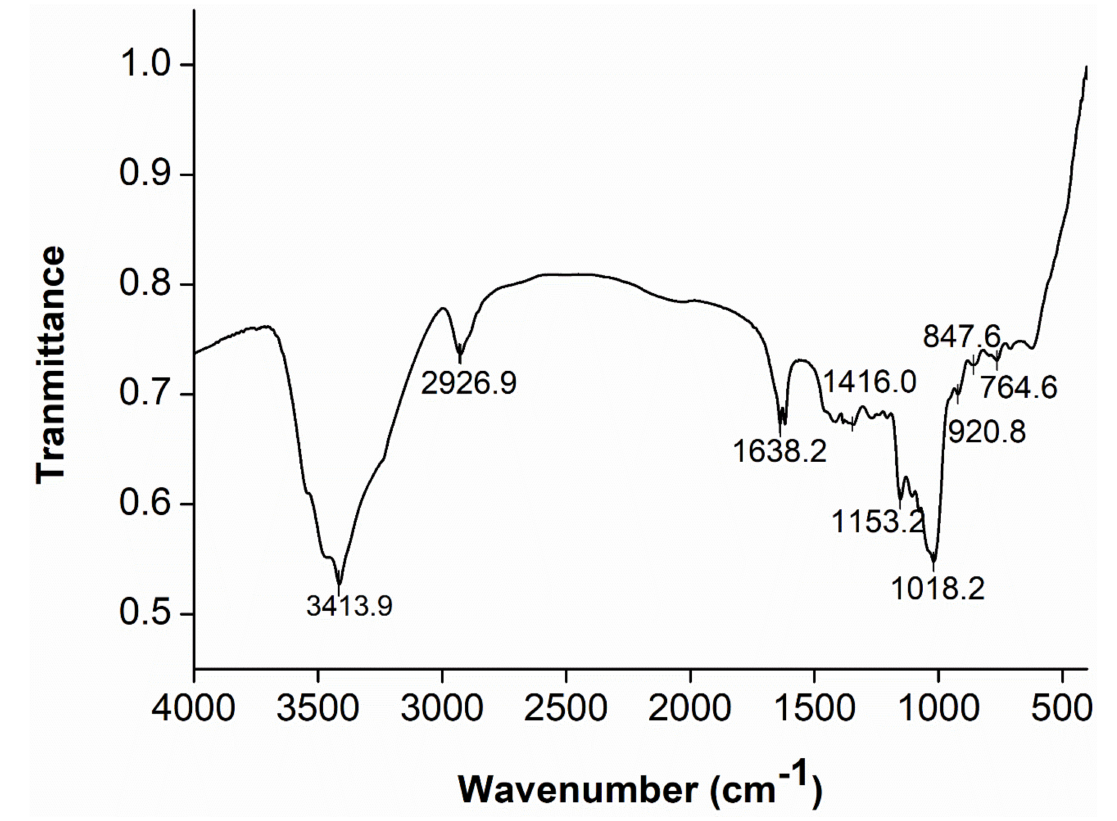
Figure 3. FT-IR analysis of the purified M-EPS over the range 400 to 4000 cm − 1